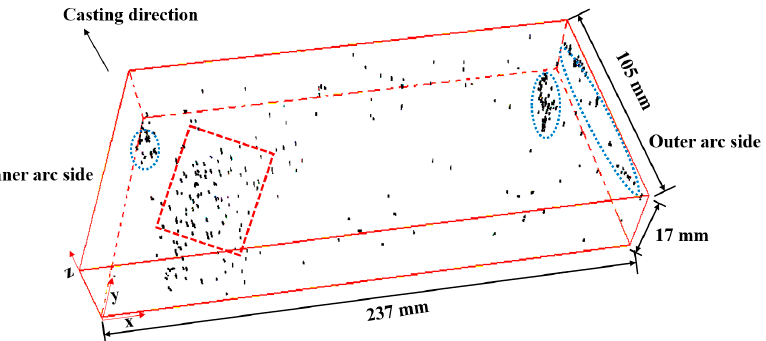
Figure 5. Three-dimensional distribution diagram of different angle nonmetallic inclusions in the edge of the slab.